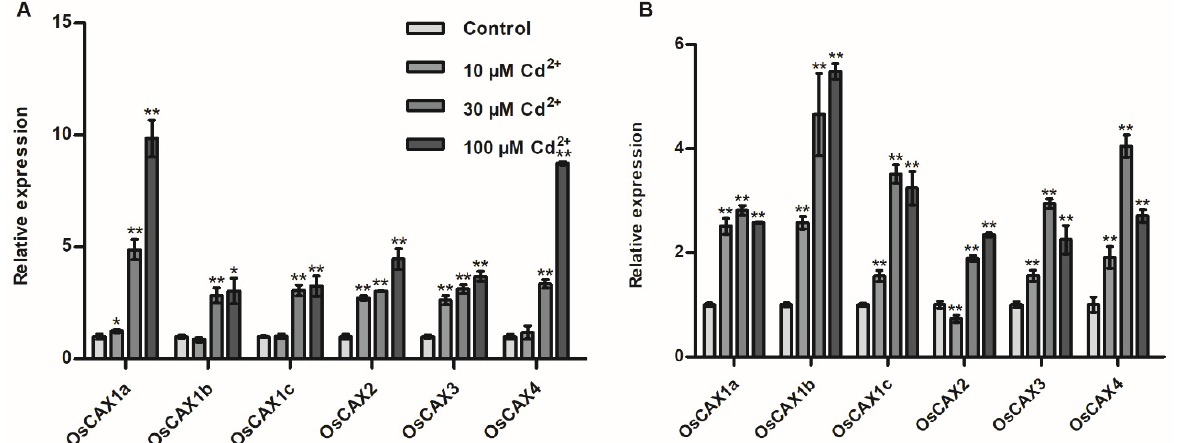
Figure 2. Expression of rice CAX genes under CdCl 2 treatments. The relative transcript levels were quantified by qRT–PCR in ( A ) roots and ( B ) leaves (mixed collection of shoots and leaves) of rice variety Nipponbare grown in hydroponic culture under 0, 10, 30 or 100 µ M CdCl 2 treatment with the IRRI solution for 7 days. The rice actin gene ( Rac1 ) was used as an internal reference to normalize gene-expression data. Statistical comparison was performed by one-side t -test (* p < 0.05 and ** p < 0.01). Values are mean ± SE ( n = 3, three replicates with tissues being collected from three plants per replicate, three plants per pool).